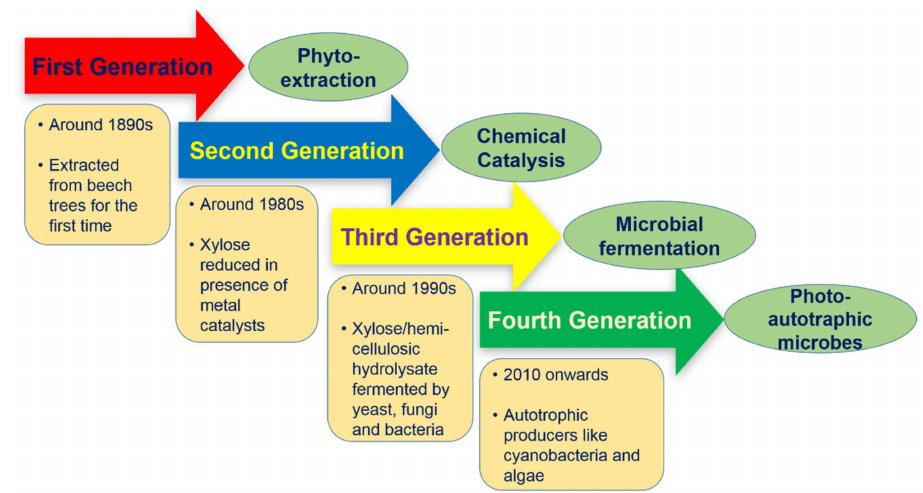
Figure 1. Generations of xylitol production from various substrate and catalytic agents. The journey began with the extraction of xylitol from wood (first generation) followed by catalytic reduction of xylose or xylose rich hydrolysate by metal catalysts (second generation). Bioprocessing, which uses photoautotrophic microorganisms developed / engineered to produce xylitol, predominates from the third generation